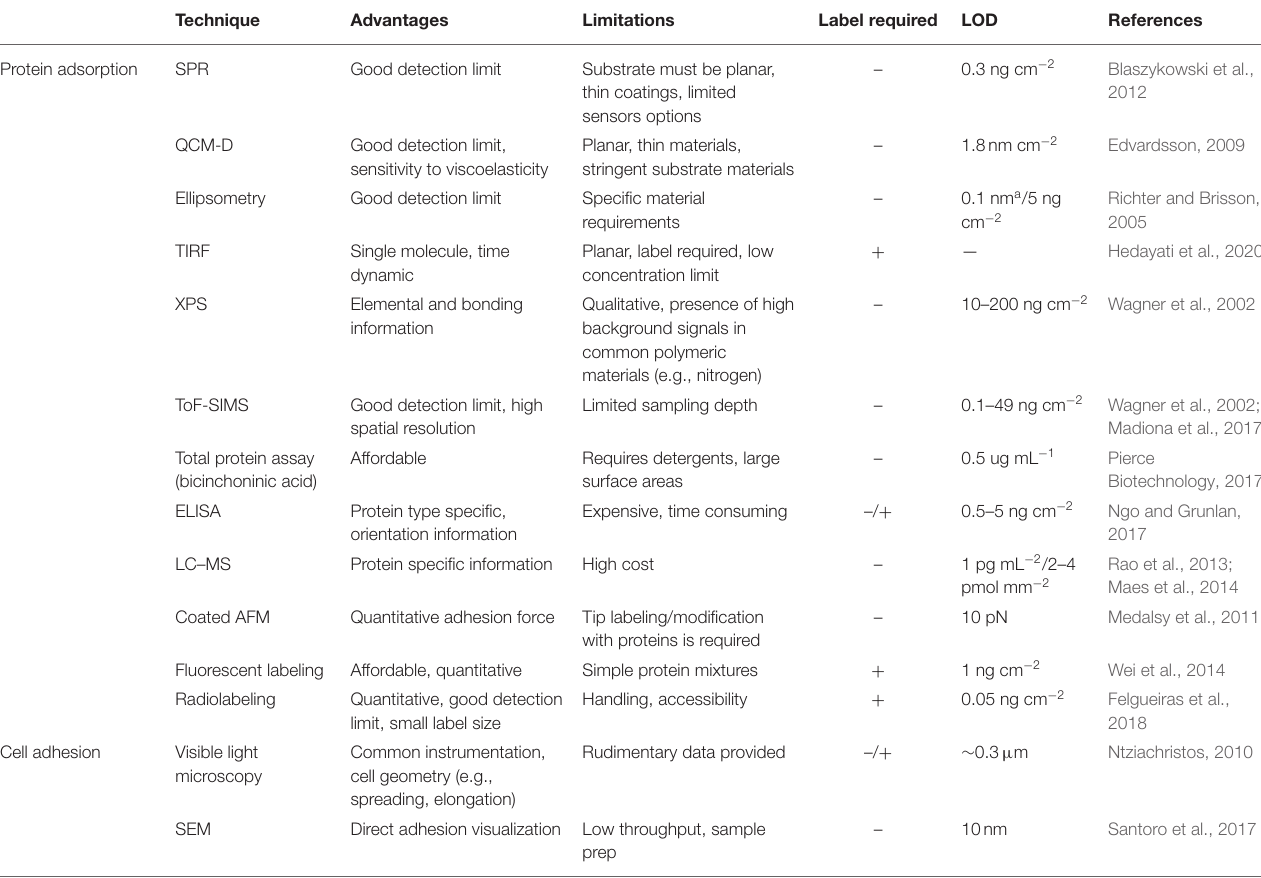
TABLE 2 | Advantages and limitations of commonly employed techniques to characterize protein adsorption and cell